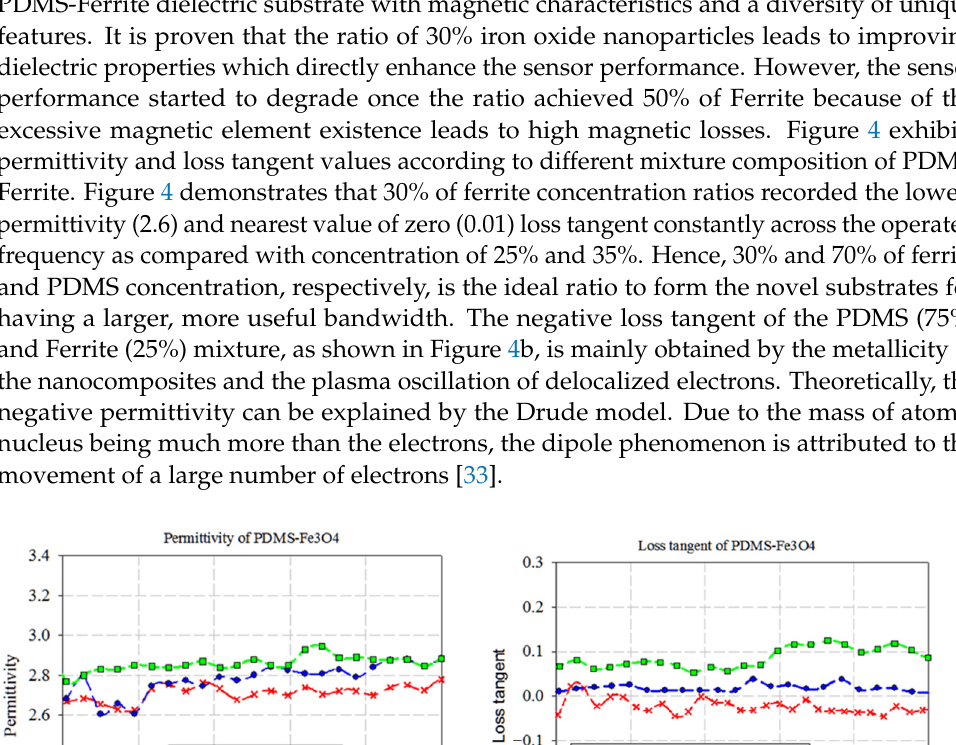
Figure 3. The synthesized Magnetite PDMS Graphene Array Sensor.